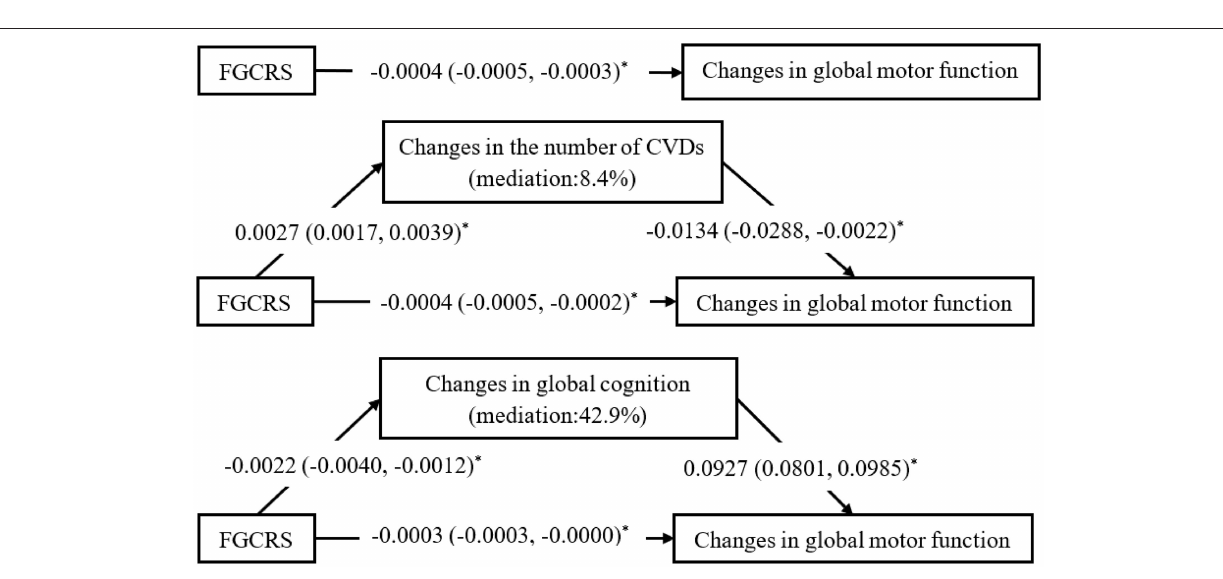
Frontiers in Medicine |